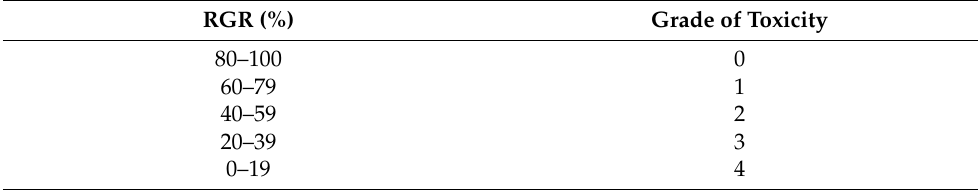
Table 4. Grade of toxicity.